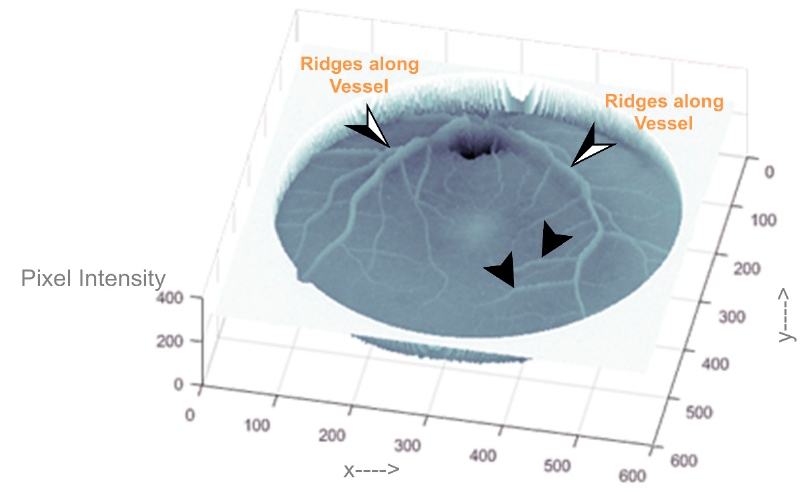
Figure 11. Graphical representation of ridges along retinal vasculature tree.